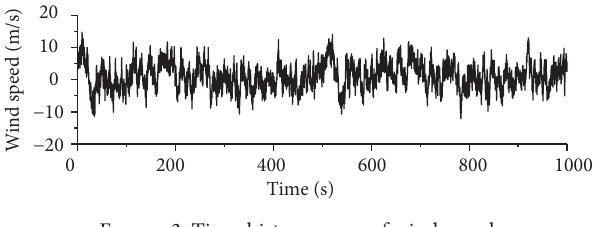
Figure 3: Time-history curve of wind speed.